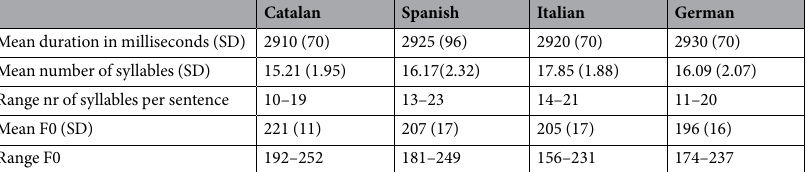
Table 1. Mean and Standard Deviation in parenthesis of the duration, number syllables and F0 values per sentence in each of the